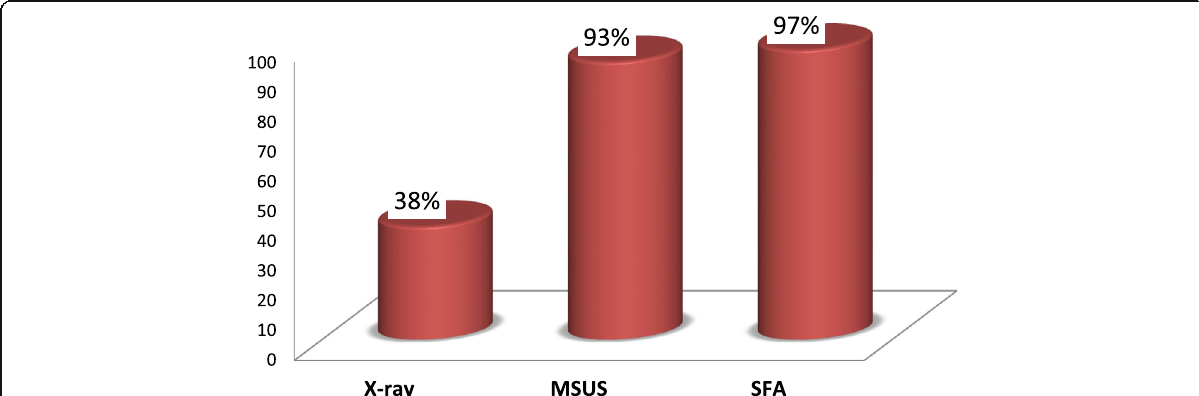
Fig. 5 Percent of the diagnosis of CPPD deposition by conventional plain radiography, MSUS and synovial fluid analysis. The accuracy of MSUS to diagnose CPPD calcification is more than double that of X-ray, and it is comparable to that of synovial fluid analysis